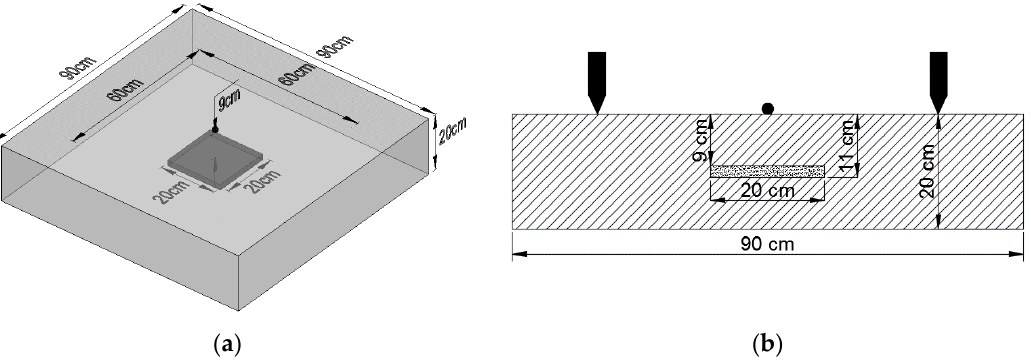
Table 1. Expected peaks for plate with voids ( C pp = 3834 m/s).